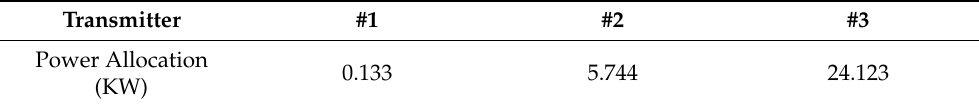
Table 6. Receiving antennas